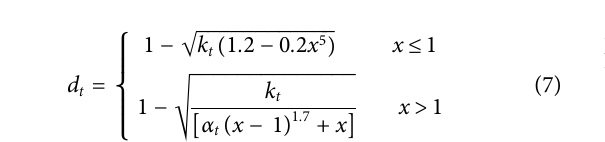
Frontiers in Materials |